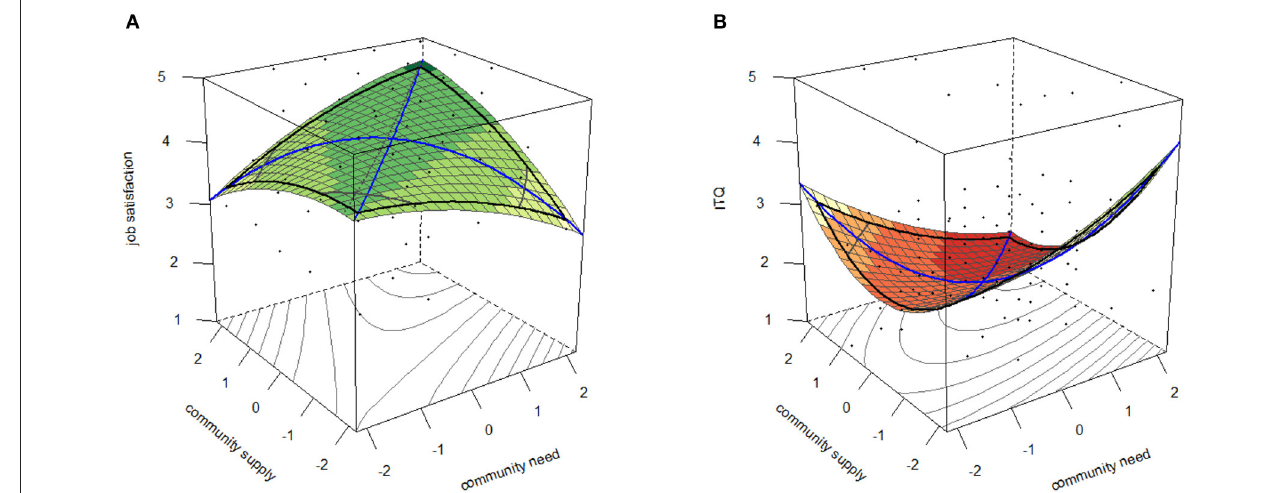
FIGURE 2 | Surface plots of community need and supply on job satisfaction (A) and intent to quit (B)